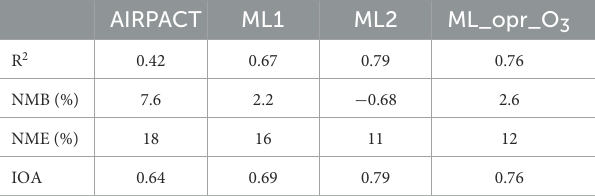
TABLE 2 Statistics of the 10-time, 10-fold cross-validation of the MDA8 O 3 predictions from AIRPACT and our ML models.